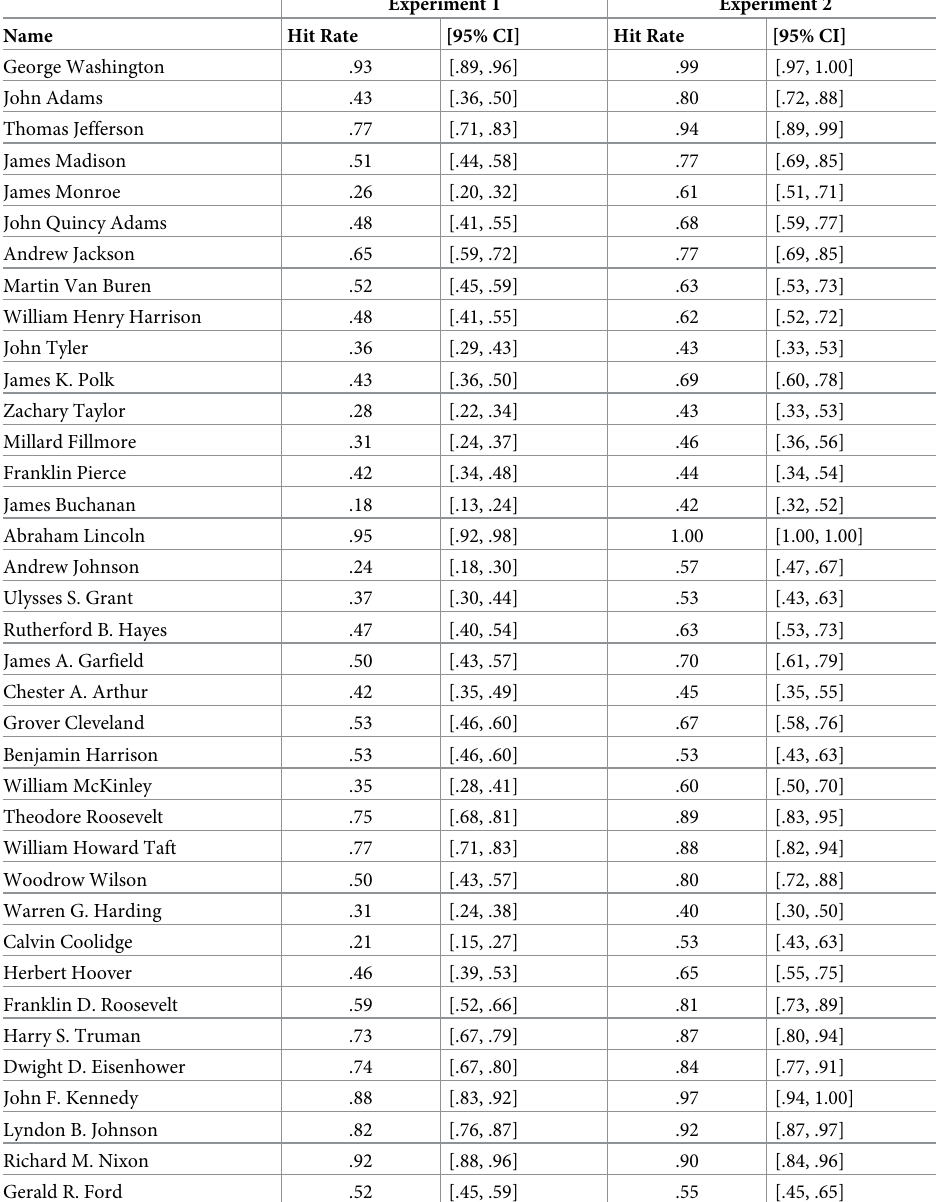
Table 2. Proportion of subjects who correctly identified presidents as presidents in Experiments 1 and 2, in order of when they served their first term.